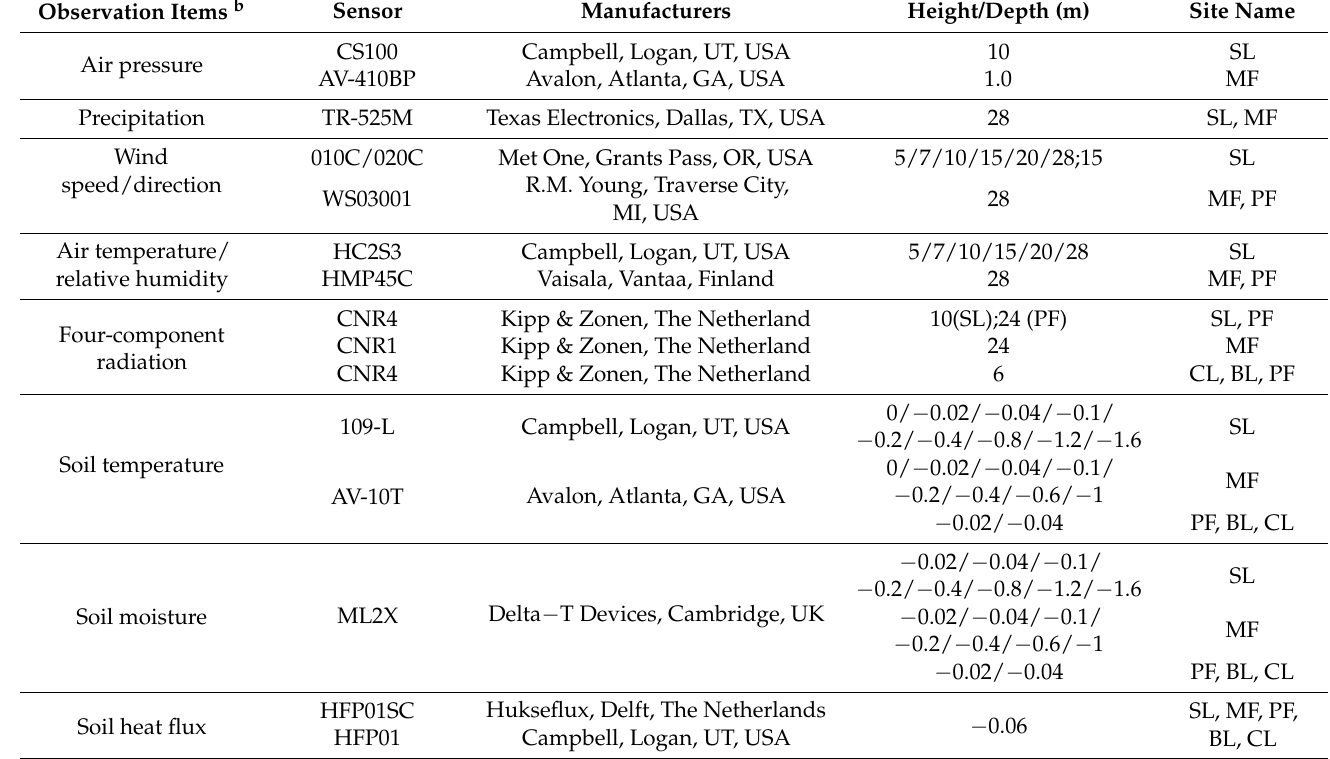
Table 2. Details of the meteorological instruments at five AWSs within the intensive observation area in